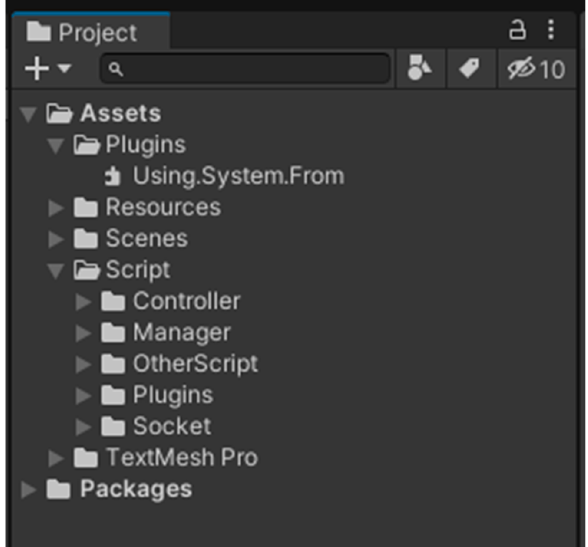
Figure 4. The created directory structure.